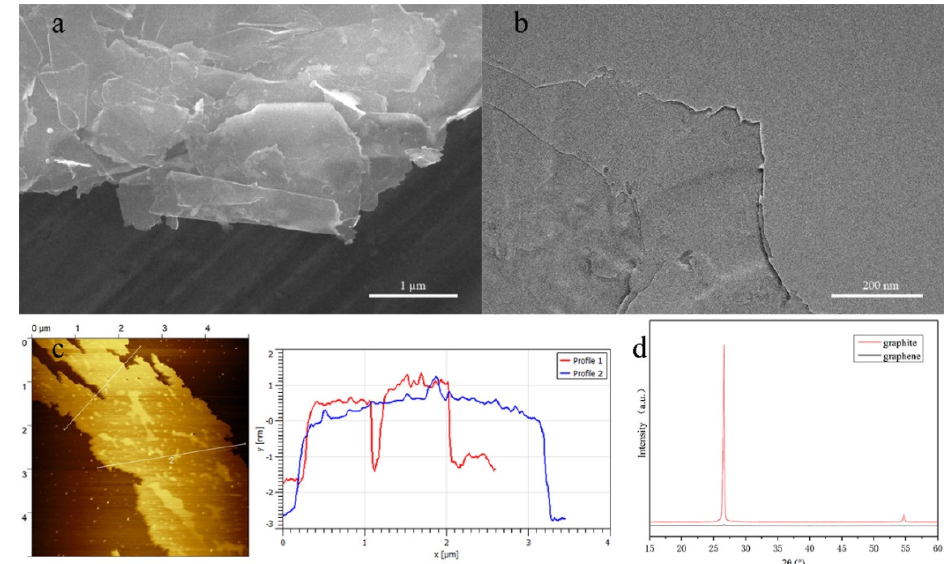
Figure 5. Microscopic morphology photos of rubber exfoliated graphene. ( a ) SEM; ( b ) TEM; ( c ) AFM image and graphene thickness change curve; ( d ) X-ray diffraction (XRD) analysis curve of graphite, and exfoliated graphene [70]. Reprinted with permission from ref. [70]. Copyright 2019 UNIV HEBEI TECHNOLOGY, 201910640615.3, China patent.